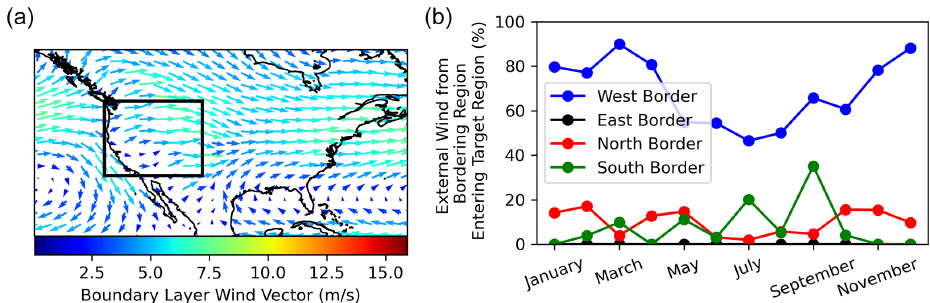
Figure 2. (a) Annual mean lower troposphere (surface up to approximately 700mbar) wind conditions from MERRA2. The Western US target domain is identified with borders. Averaged conditions in each month are shown in Fig. S3. (b) Proportion of wind vector entering region from each bordering region. Values do not add to 100% as each border’s wind vector is evaluated individually for its contribution to the Western US domain.